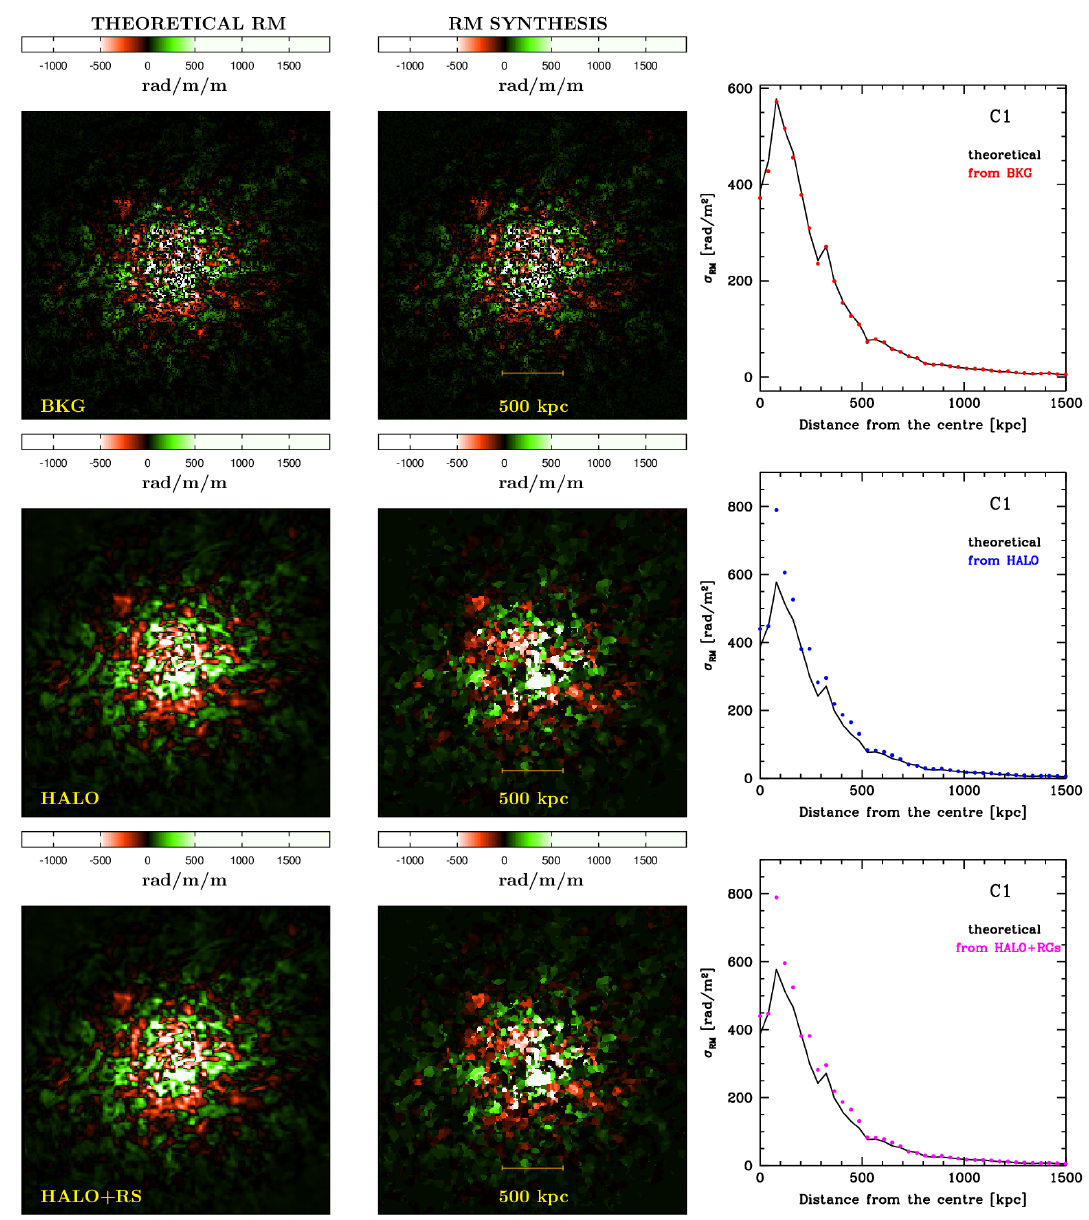
Figure 2. From left to right: Theoretical rotation measure (RM) as computed from the magneto-hydro-dynamical (MHD) cubes, results of the RM synthesis applied on U,Q Stokes simulated cubes, profile of the theoretical RM compared to what measured in the RM synthesis image for, respectively, the background discrete radio sources ( top ); the radio halo ( middle ); and the foreground, background, cluster-embedded diffuse and discrete sources ( bottom ) of the galaxy cluster on the left in Figure